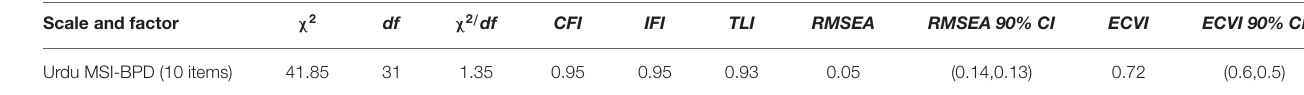
TABLE 3 | The fit indices of the model of the Urdu MSI-BPD ( N = 150). Scale and factor χ